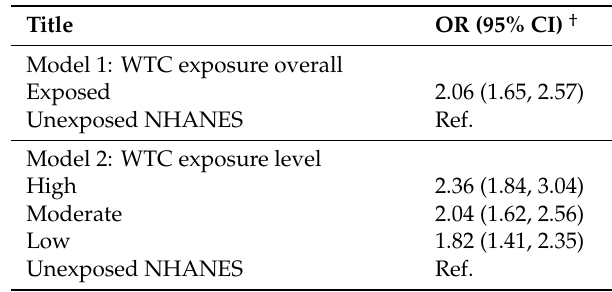
Table 4. Multivariable logistic regression using the NHANES 2003–2004 non-diabetic cohort as a national referent